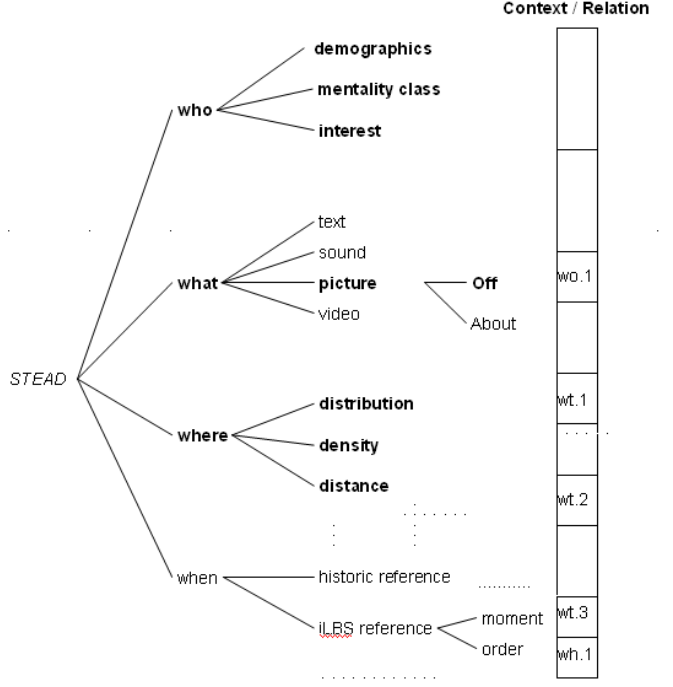
Figure 9. Overview of the STEAD approach ( bold : presented by the